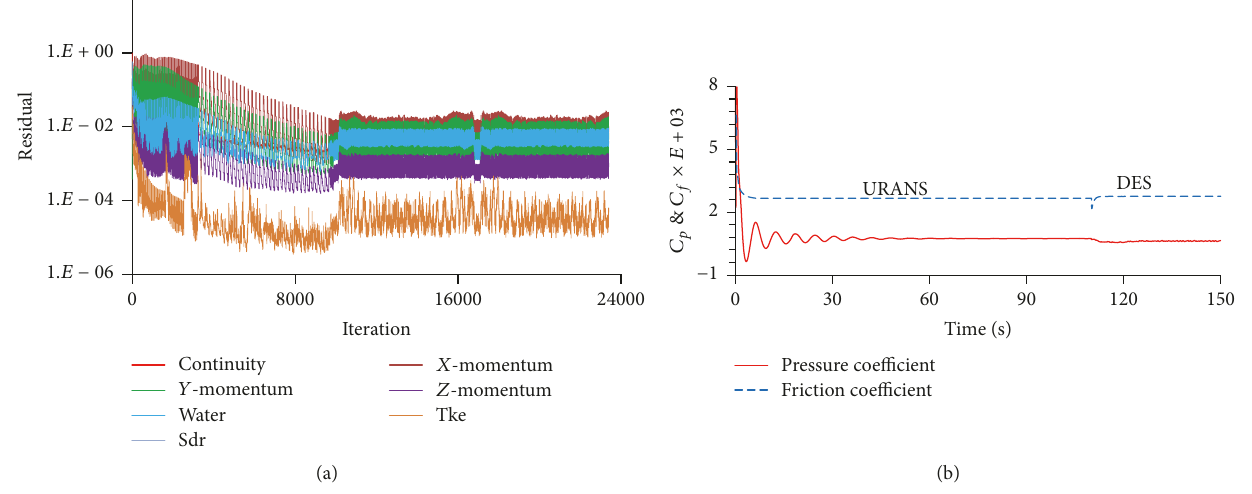
Figure 5: (a) Residuals monitoring plot and (b) time history curves of ship’s pressure and friction resistance coefficients (Fn = 0.26 ).